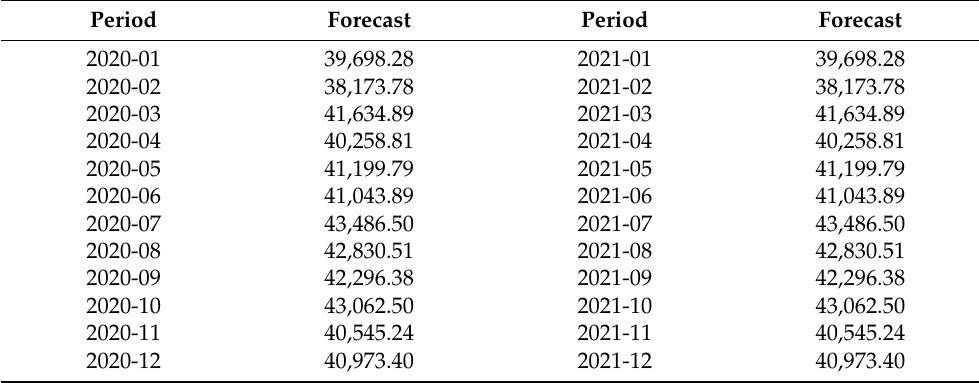
Table 8. Forecast errors. Source: own elaboration. Mean Absolute Error Mean Error (ME)